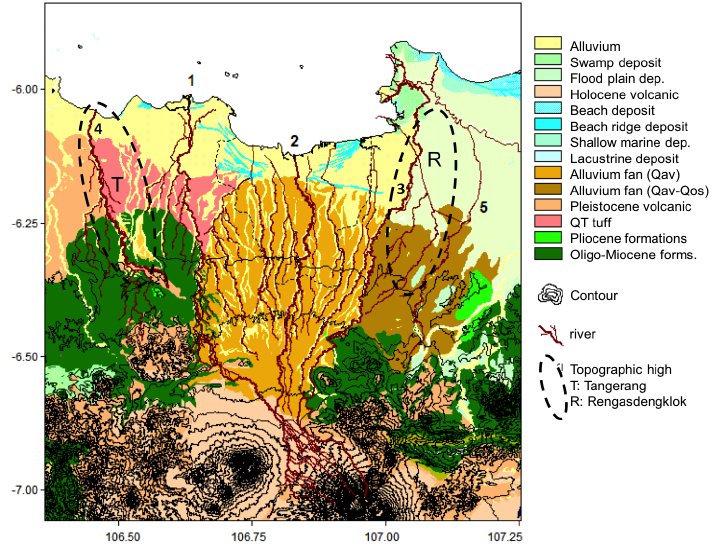
Figure 3. Contour lines and drainage patterns overlaid on a map of surface geology show the funnel-shaped basin, bounded by the Cisadane (1) and Kali Bekasi (3) Rivers in the west and east, respectively. Mountains from which the Cisadane (1), Ciliwung (2) and Kali Bekasi (3) Rivers sprout form the narrow base of a funnel-shaped topographic low with Jakarta Bay at its mouth. The Cimanceuri River is labeled as (4). The SN Line is the cross-section used in the numerical simulation. Tangerang and Rengasdengklok Highs are indicated by dashed lines, labeled T and R,